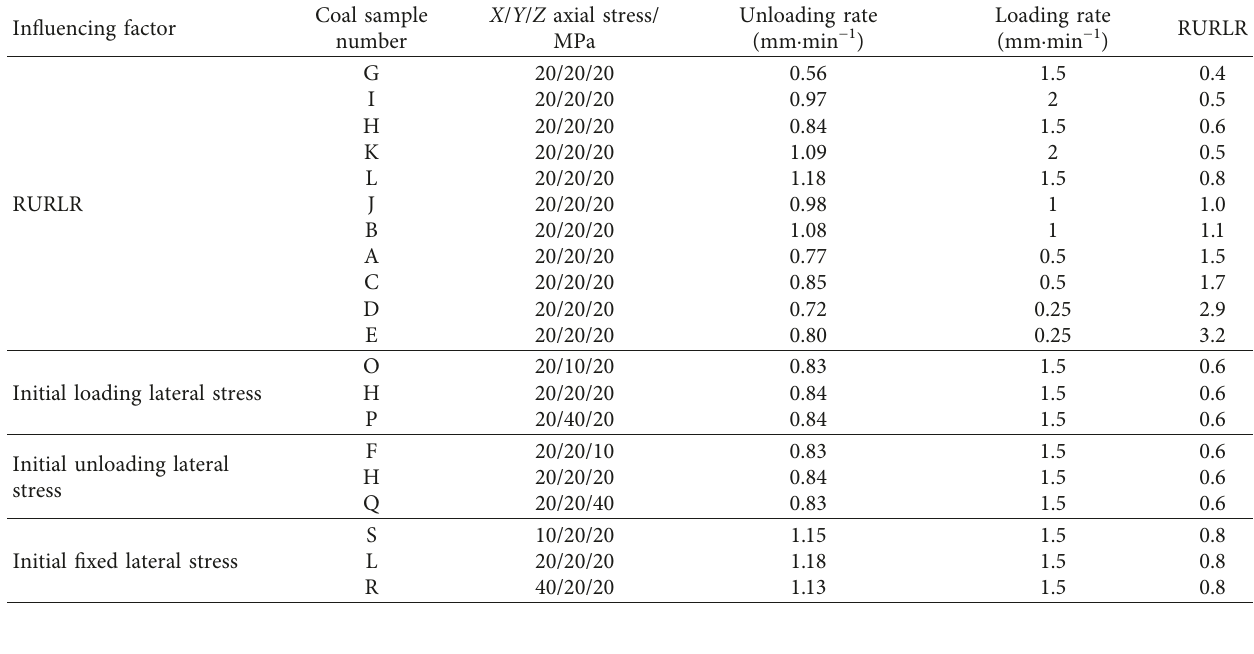
Table 2: Experimental